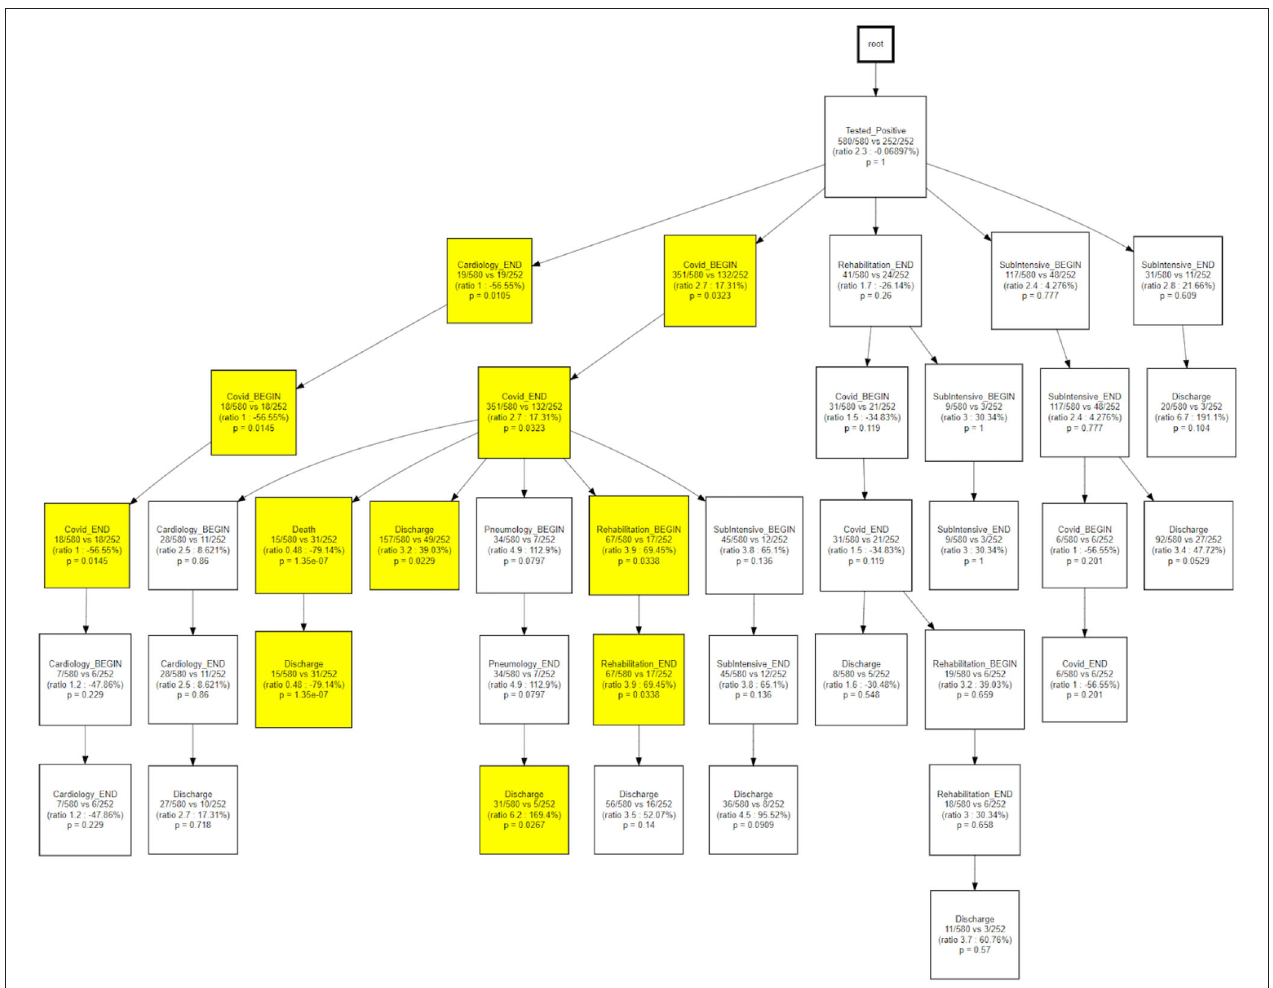
FIGURE 12 | CareFlow miner results - comparison of trajectory 1 with trajectory